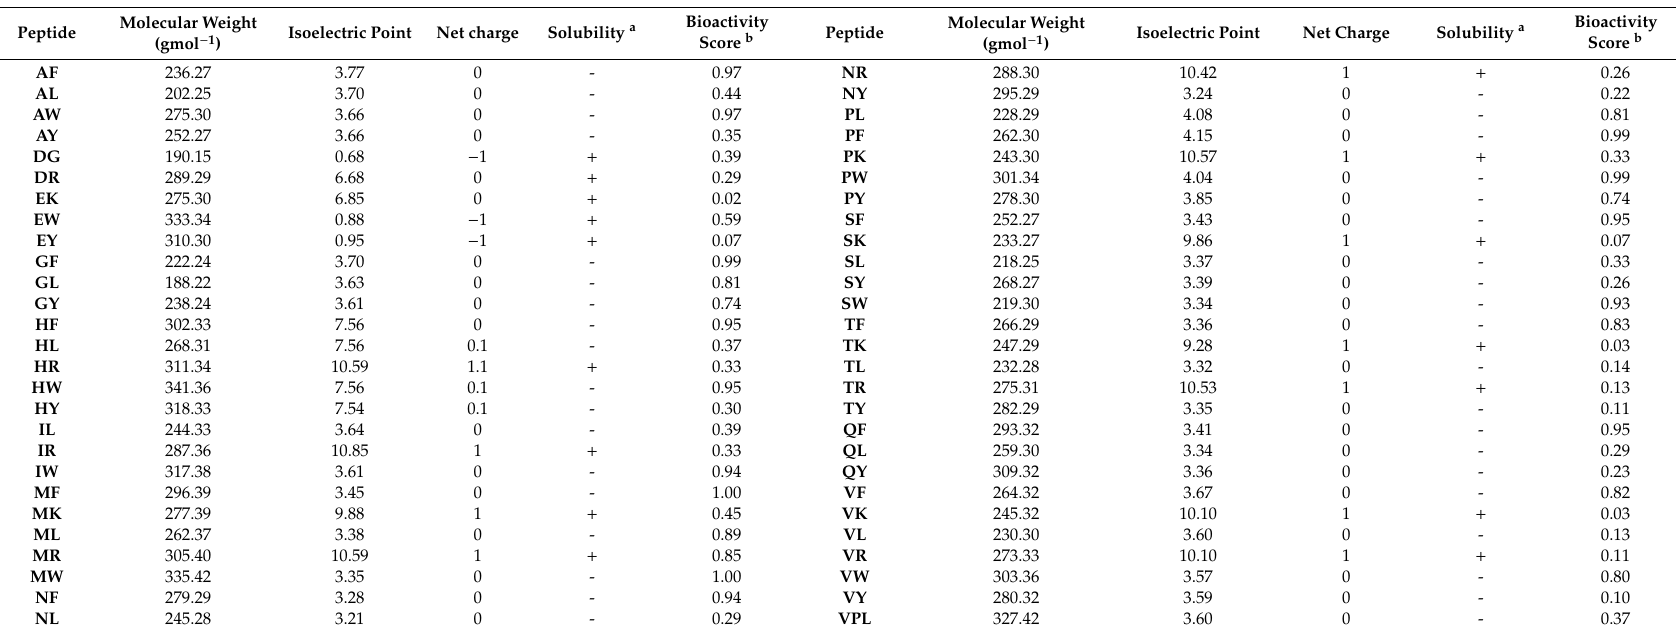
Table 5. The results of the analysis of the physico-chemical properties of selected antidiabetic